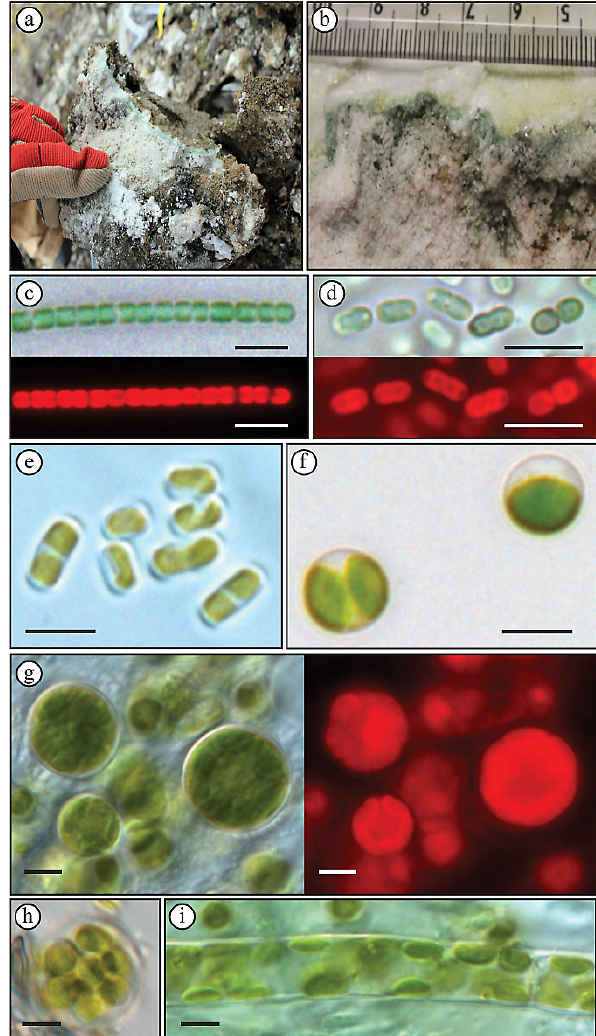
Fig. 2. (a) Field sample of gypsum containing endolithic microor- ganisms. Note green banding beneath surface crust (b) . Both fila- mentous and coccoid cyanobacteria (c, d) and algae (e–i) were cul- tured from collected samples, with photosynthetic pigment autoflu- orescence showing cell